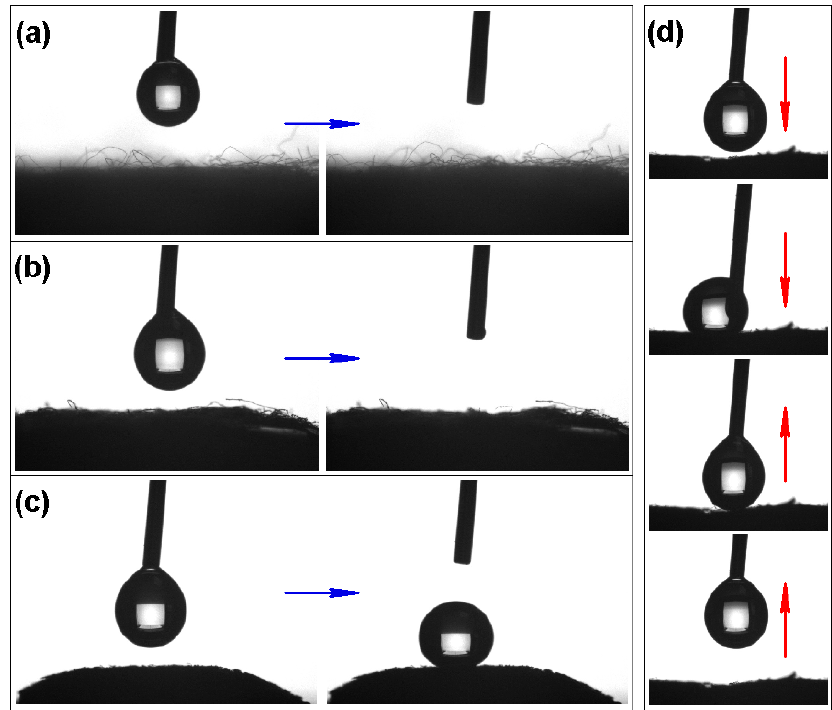
Figure 7. ( a – c ) The water static contact angle measurement for CBs, ZIF-8/CNTs/CBs, and 8 of 11